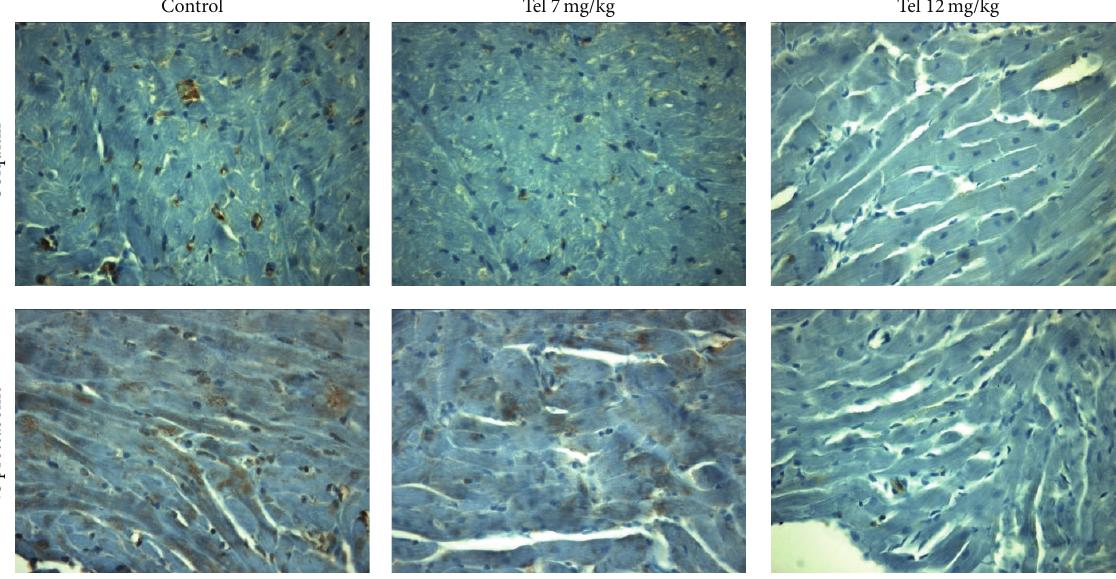
Figure 1: Telmisartan (tel) reduces the expression of 20S proteasome and ubiquitin in infarcted heart tissue of rats as shown by immun-